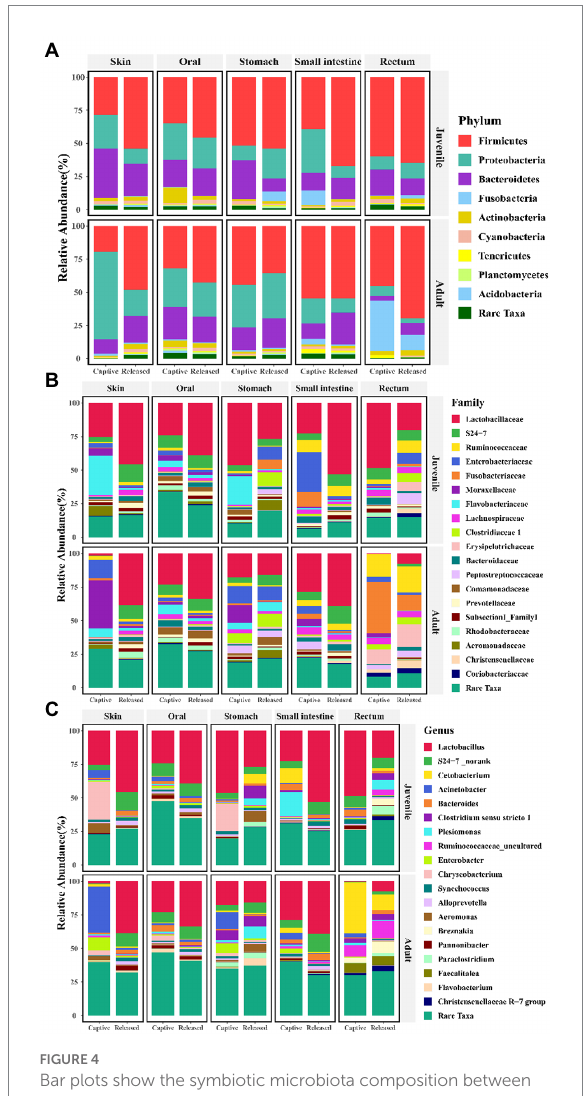
FIGURE 4 Bar plots show the symbiotic microbiota composition between captive bred and released individuals at phylum (A) , family (B) , and genus (C)